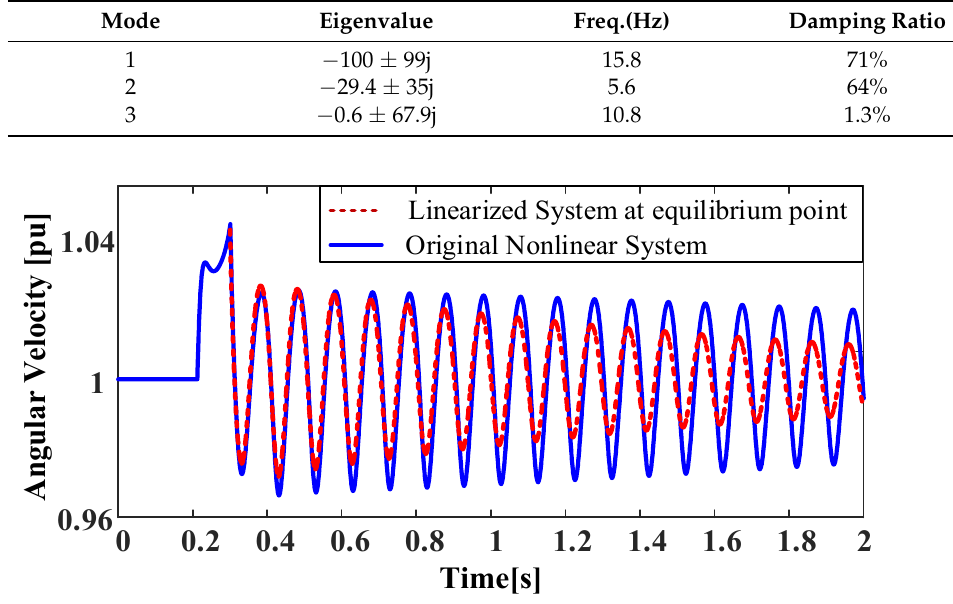
Here α ( t ) and ω ( t ) are defined as instantaneous amplitude attenuation ratio and oscillation frequency, respectively. If the oscillation is linear, α ( t ) and ω ( t ) are constantly determined by mode three. However, due to nonlinearity, α ( t ) and ω ( t ) change with time. In order to obtain α ( t ) and ω ( t ) , Hilbert transform of x ( t ) is utilized and y ( t ) can be attained represented